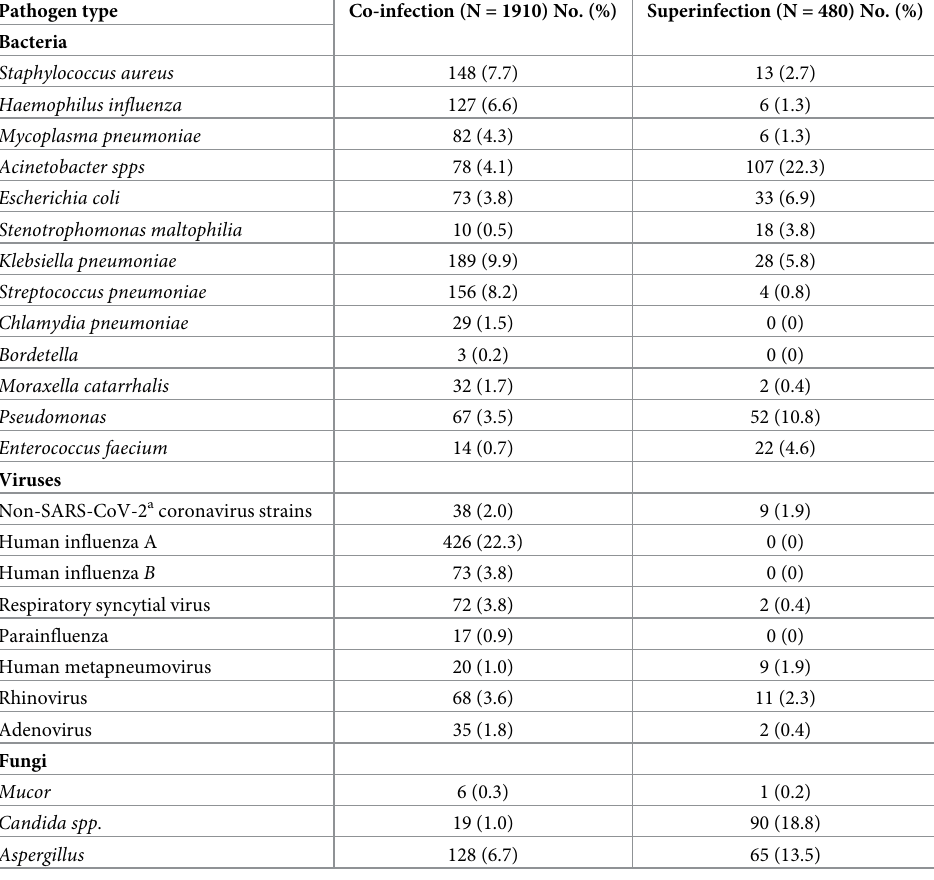
Table 2. All identified organisms as a proportion of total number of organisms per